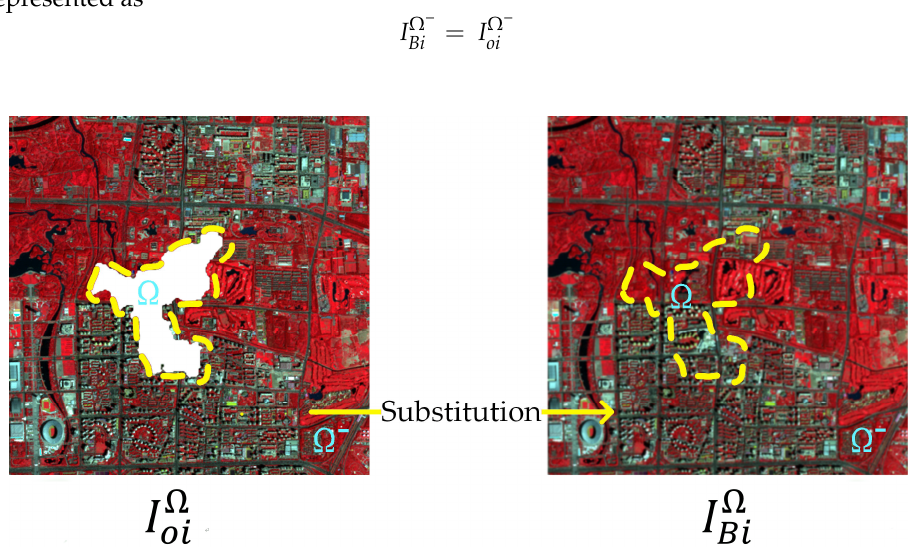
Figure 6. Explanation of substitution.